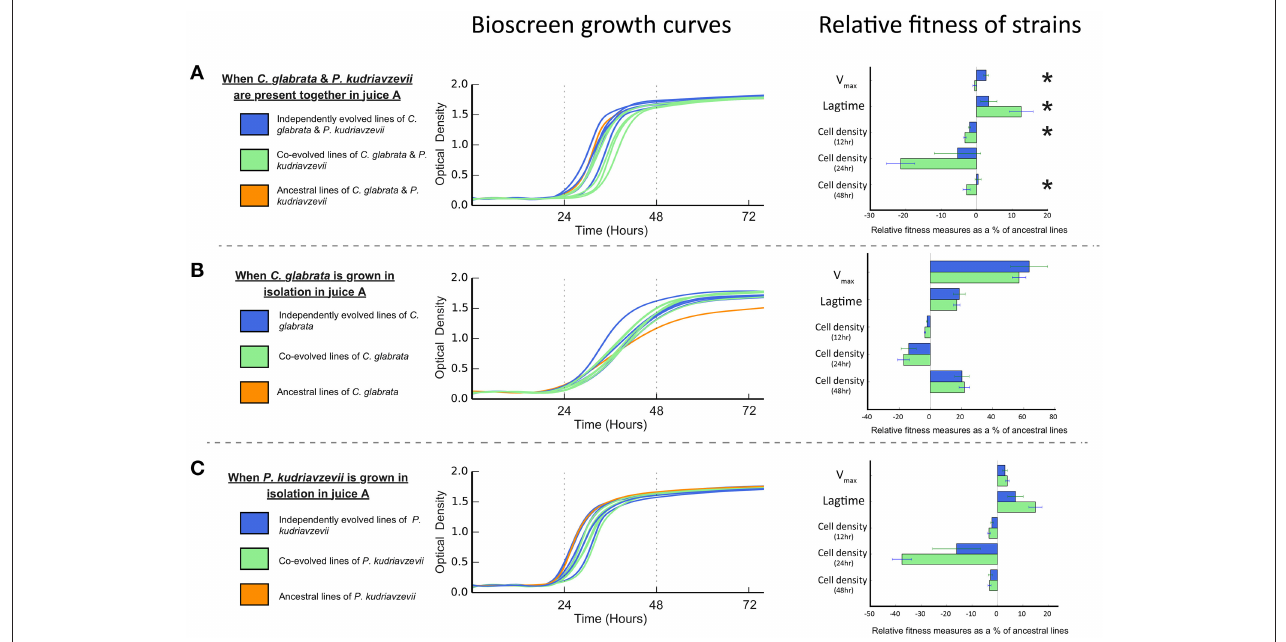
FIGURE 3 | Bioscreen growth curves and relative fitness measures in juice A of co-evolved, independently evolved, and ancestral lines of (A) C. glabrata and P. kudriavzevii when grown together. (B) C. glabrata when grown in isolation. (C) P. kudriavzevii when grown in isolation. Relative fitness measures—V max , lagtime, and cell densities—are expressed as the proportional difference between evolved lines and the ancestral line. Significant differences between co-evolved and independently evolved strains are denoted by “ ∗ ”.